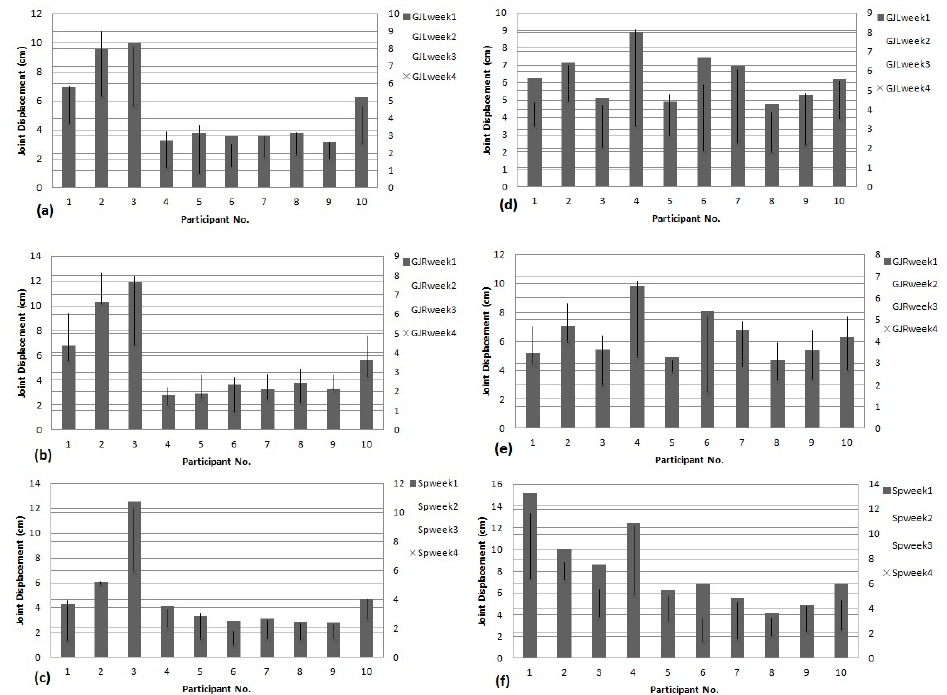
Figure 9. Joint displacement of participants during a four-week training period. DSP: dumbbell shoulder press; LR: lateral raise; GJLweek1: glenohumeral left joint week 1; GJRweek1: glenohumeral right joint week 1; Spweek1: spine week 1; GJRweek2: glenohumeral right joint week 2; Spweek2: spine week 2; GJLweek2: glenohumeral left joint week 2; GJRweek3: glenohumeral right joint week 3; Spweek3: spine week 3; GJLweek3: glenohumeral left joint week 3; GJRweek4: glenohumeral right joint week 4; Spweek4: spine week 4; GJLweek4: glenohumeral left joint week 4. ( a ) left glenohumeral joint displacement for DSP; ( b ) right glenohumeral joint displacement for DSP; ( c ) spine displacement for DSP; ( d ) left glenohumeral joint displacement for LR; ( e ) right glenohumeral joint displacement for LR; ( f ) spine displacement for